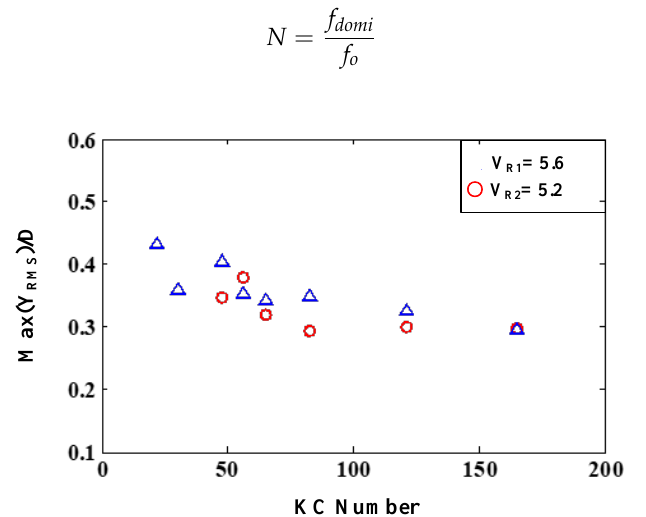
Figure 19. The maximum root mean square VIV displacement responses versus KC numbers under different dominated modes.